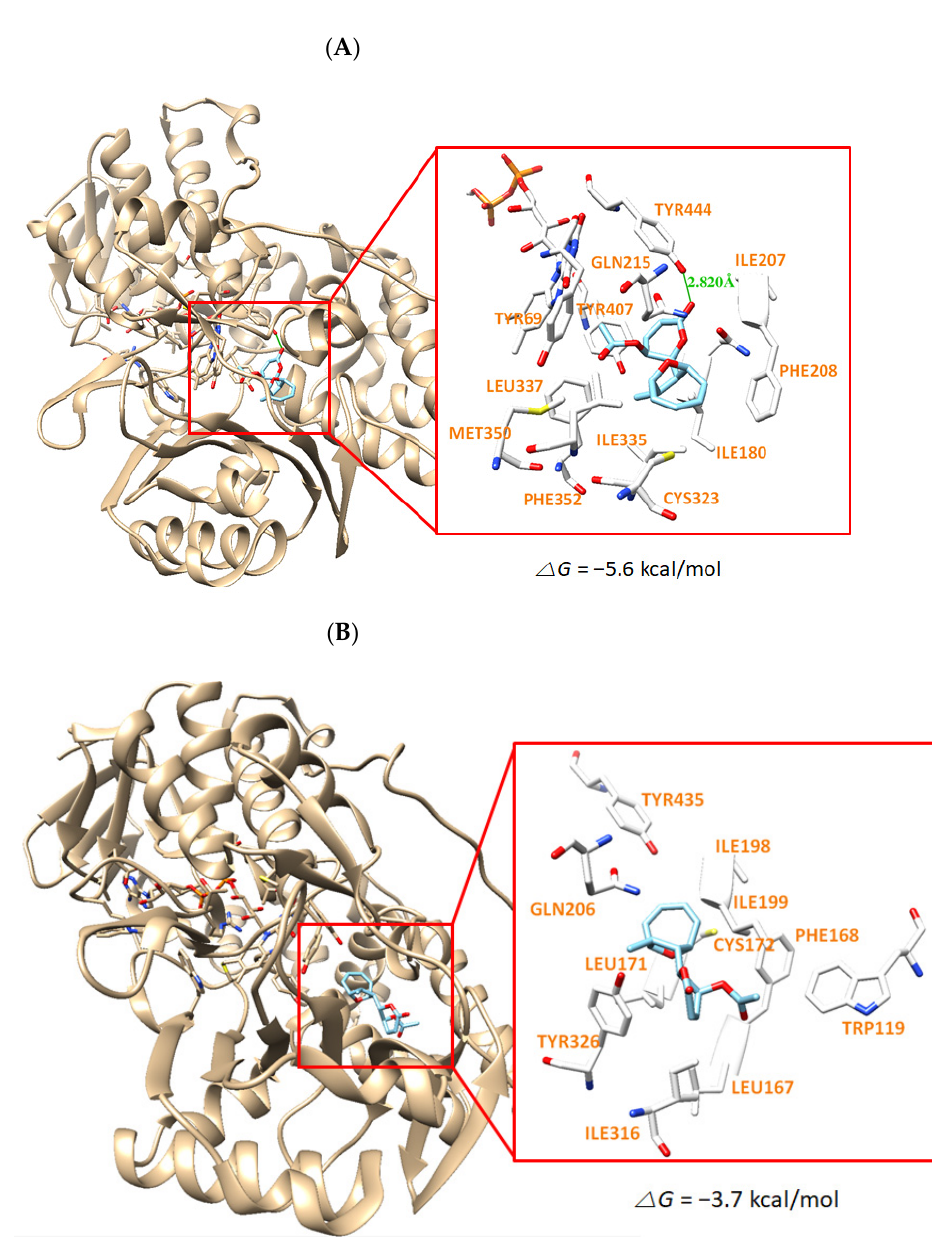
Figure 7. The docking simulation of MED with hMAO-A (2Z5X) ( A ) and hMAO-B (3PO7) ( B ) as determined by the UCSF Chimera. MED interacts through a hydrogen bond with Tyr444 residue of hMAO-A at a distance of 2.820 Å.